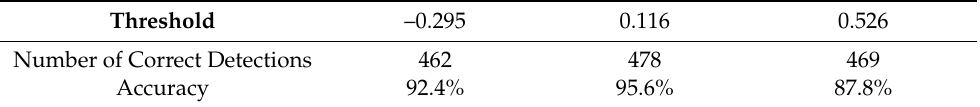
Table 4. Fatigue detection accuracy of different thresholds in the case of segment number n = 3 by using the time cumulative effect model.